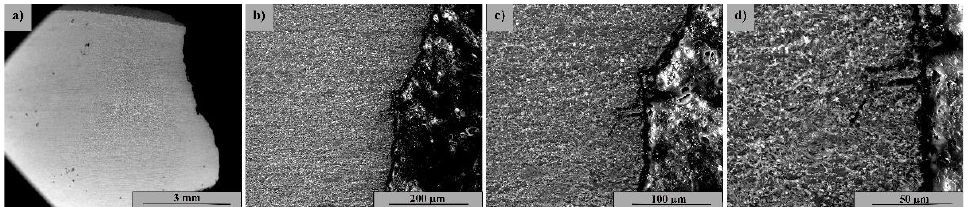
Figure 14. Microstructures from sample K in the breakage area: ( a ) Macroscopic view; ( b ) 500×; ( c ) 1000×; ( d ) 2000×.